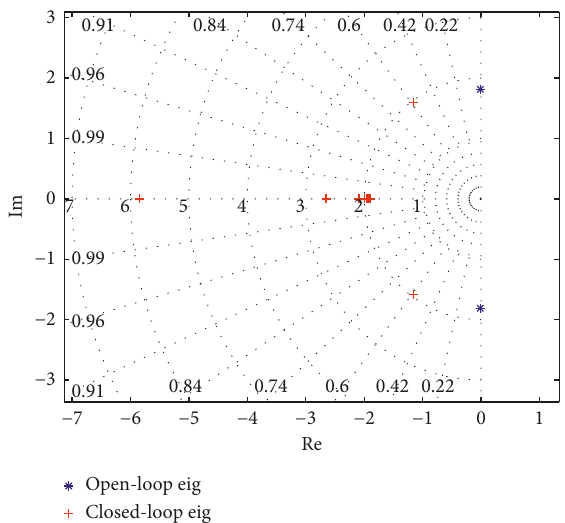
Figure 10: Dominant poles for LQ controller design, ζ